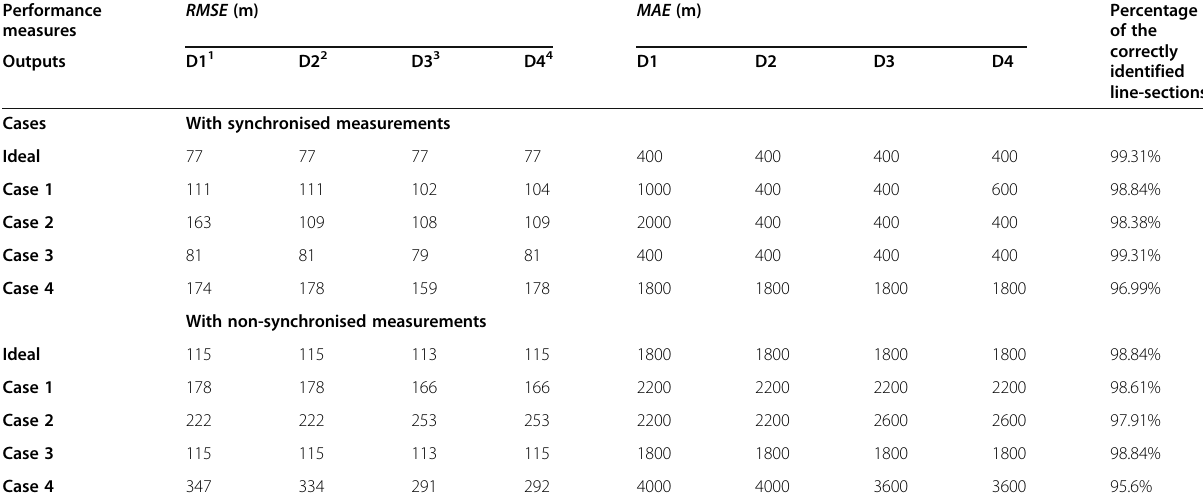
Table 3 RMSE and MAE values and the Percentage of the correctly identified line-sections for all test scenarios Performance